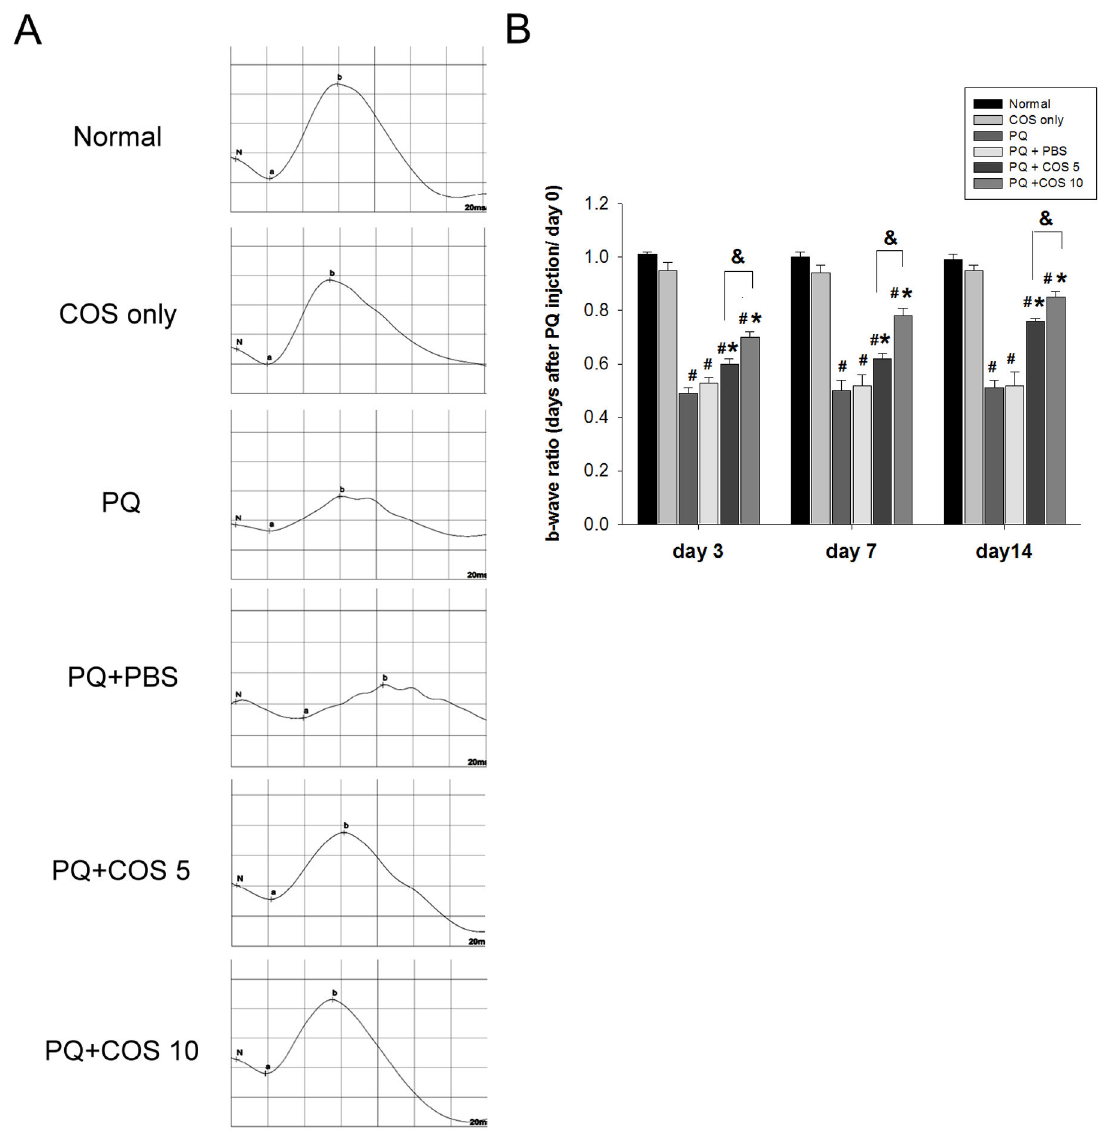
Figure 1. Chitosan oligosaccharides (COS) treatment attenuated reduction of electroretinogram (ERG) b- wave amplitudes. (A). Individual typical ERG records of the six groups 14 days after PQ injection. (B). Mean ERG b-wave amplitude was measured at day 3, 7 and 14 after PQ injection. The b-wave ratio was defined as b-wave amplitude of right eye/ b-wave amplitude of left eye at definite time point. The fold of b-wave ratio represented the b-wave ratio at day 3, 7 or 14 / b-wave ratio at day 0. The results represented six rats for each group in each time point. (* P < 0.05 compared with PQ only or PBS-treated group; # P < 0.05 compared with normal; & P < 0.05 by two-way ANOVA with post hoc Bonferroni test). doi: 10.1371/journal.pone.0077323.g001 Effects of COS on Bax/Bcl-2 ratio cleaved caspase-3 was more reduced in the high-dose COS treatment group than in the low-dose COS treatment group The Bax/Bcl-2 ratio was significantly higher in the PQ only ( P <0.01; one-way ANOVA with post hoc Bonferroni test; N=3 in and PBS-treated group than in the normal group at day 7 each group) (Figure 3C). ( P <0.001, PQ only vs. normal; P <0.001, PBS-treated group vs. normal; two-way ANOVA with post hoc Bonferroni test; N=3 in each group) and 14 ( P <0.01, PQ only vs. normal; P <0.01, PBS-treated group vs. normal; two-way ANOVA with post hoc